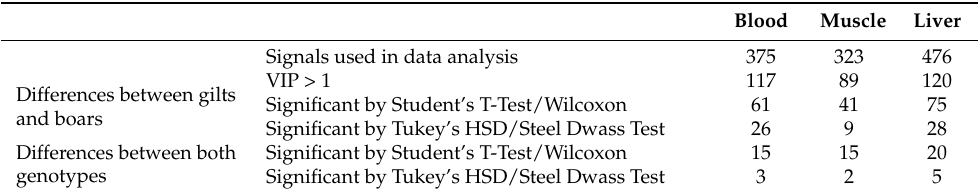
Table 1. Numbers of candidate molecules that potentially play a role in sexual metabolic dimorphism or genotype differentiation. VIP—Variable Importance